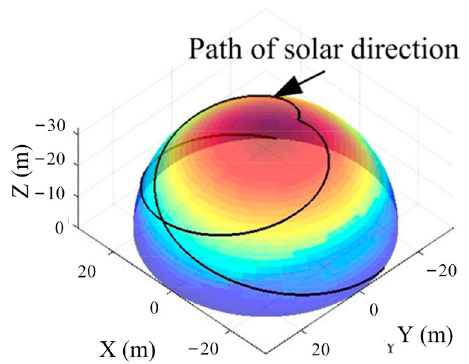
Figure 17. Energy acquisition estimation based on F CE